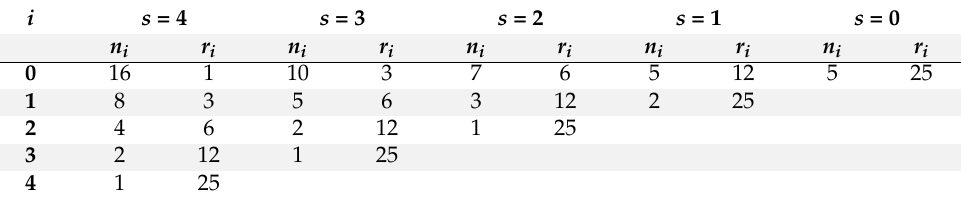
Table 5. Hyperband configuration for R = 25 and η = 3.